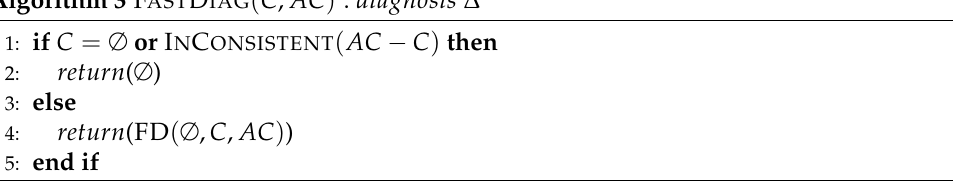
Algorithm 4 FD ( D , C = { c 1 .. c q } , AC ) : diagnosis